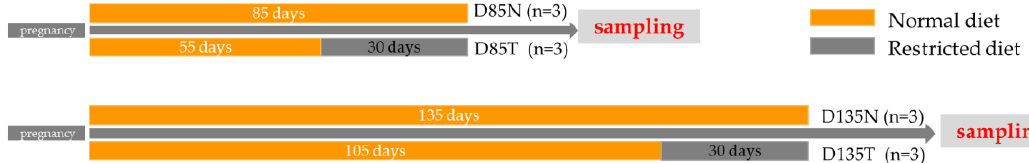
Figure 1. Dietary treatment and sampling diagram for the pregnant ewes. The long orange bar indicates the time of the maternal normal diet. The long gray bar indicates the time of the maternal restricted diets. D85N indicates the group of normal diets; D85T indicates the group of the maternal restricted diets. D135N indicates the group of normal diets; D135T indicates the group of restricted diets.